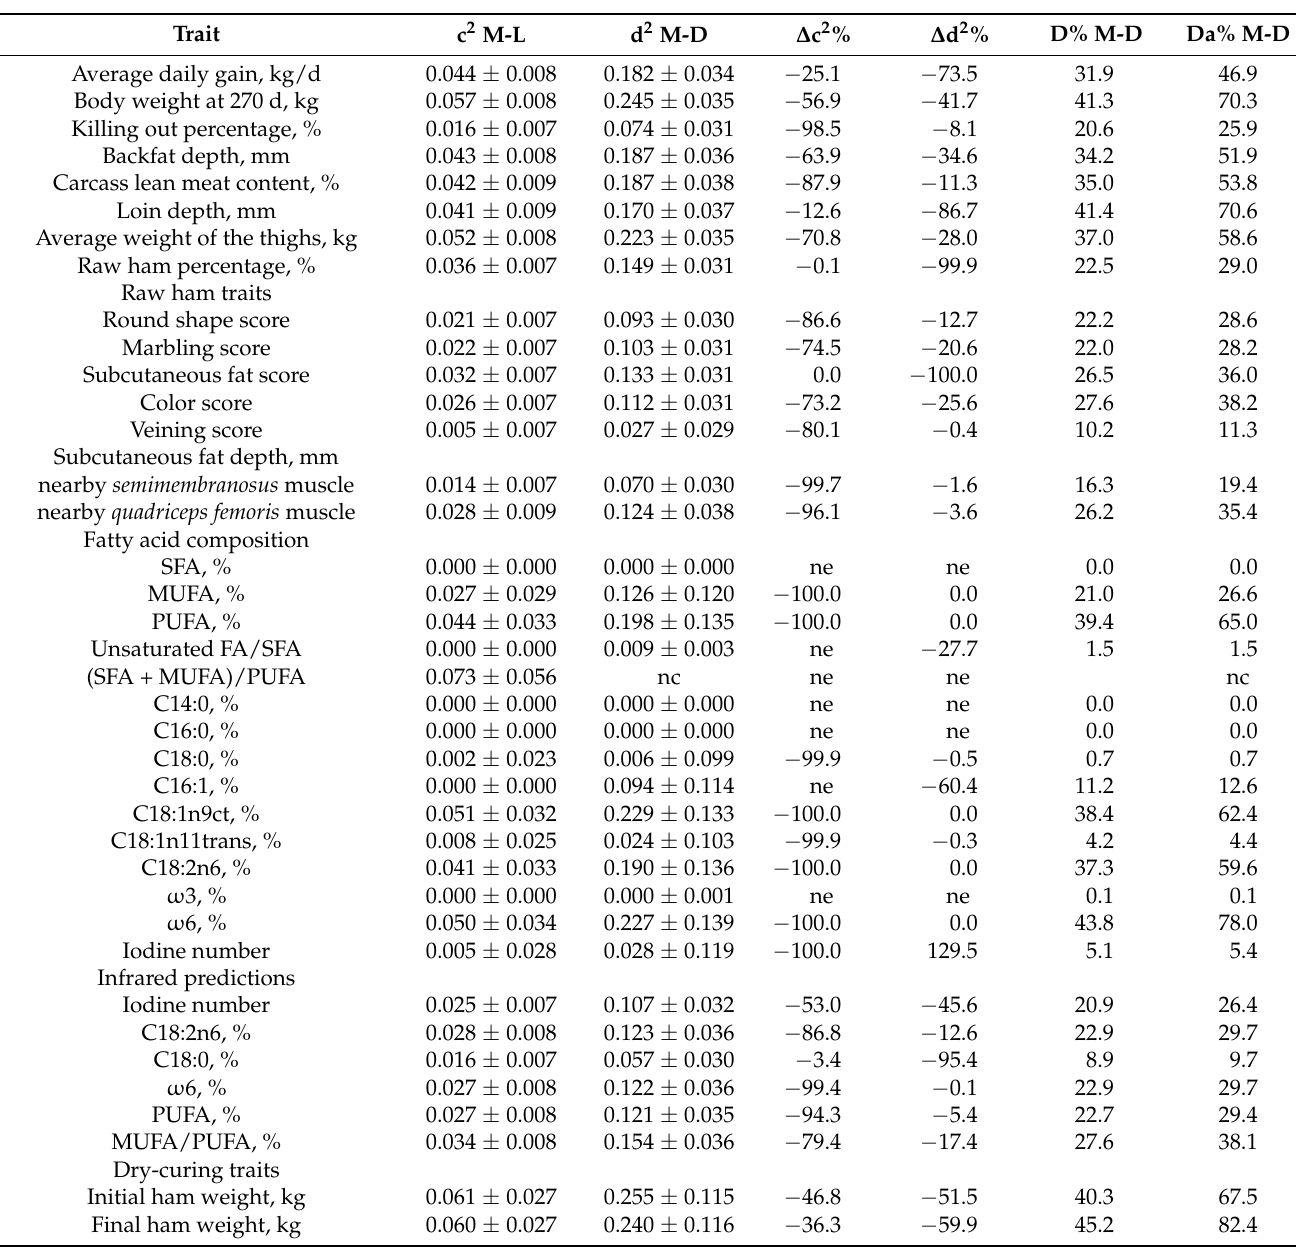
Table 4. Ratios ( ± SE) of litter (c 2 ) and dominance (d 2 ) to total variance obtained by M-L and M-D, of dominance to total genetic variance (D%) and to additive genetic variance (Da%) obtained by M-D, and percentage difference in c 2 ( ∆ c 2 %) and d 2 ( ∆ d 2 %) estimated by M-LD as compared to M-L and M-D, respectively 1